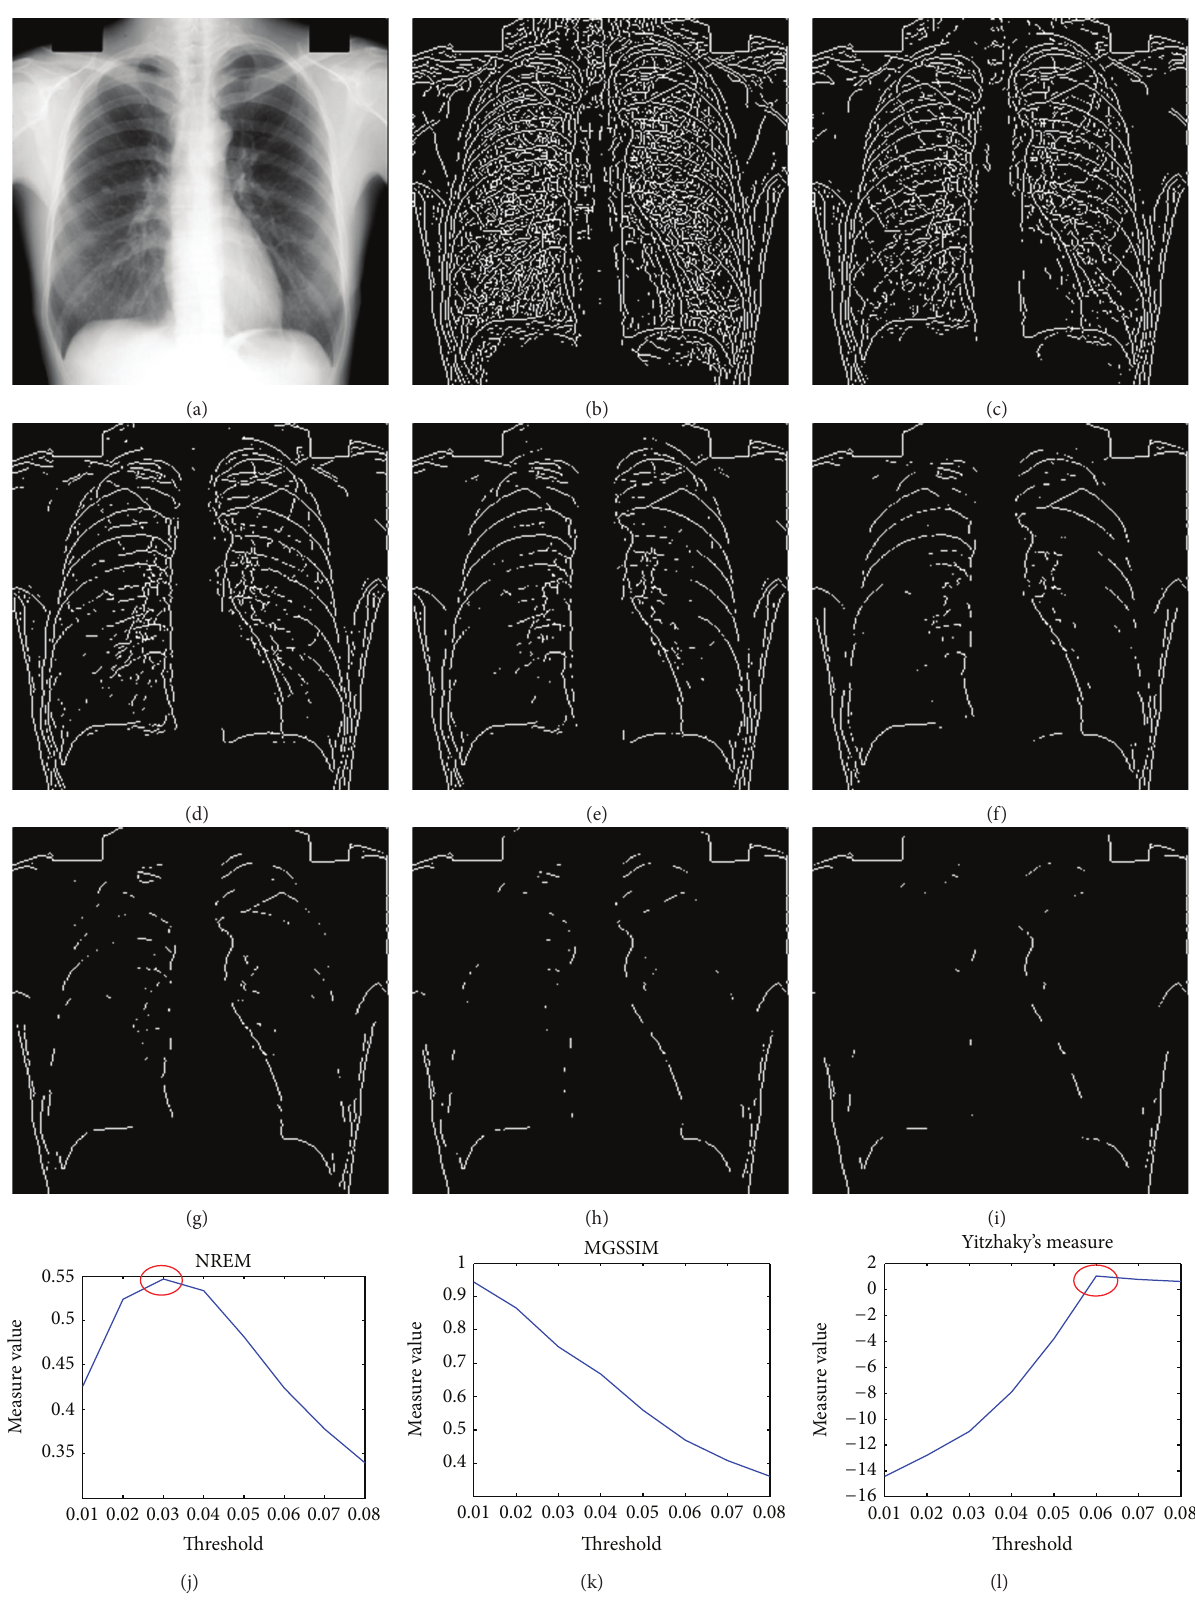
Figure 4: Applying edge measures in assisting in selecting optimal operating parameters. (a) Original X-ray chest image. (b)–(i) Edge detection results using the Sobel edge detector with the threshold ranging from 0.01 to 0.08. (j) Presented measure plot indicating 𝑇 = 0.03 as the optimal parameter value. (k) Measure plot of using MGSSIM alone. (l) Yitzhaky’s method indicating 𝑇 = 0.06 as the optimal parameter